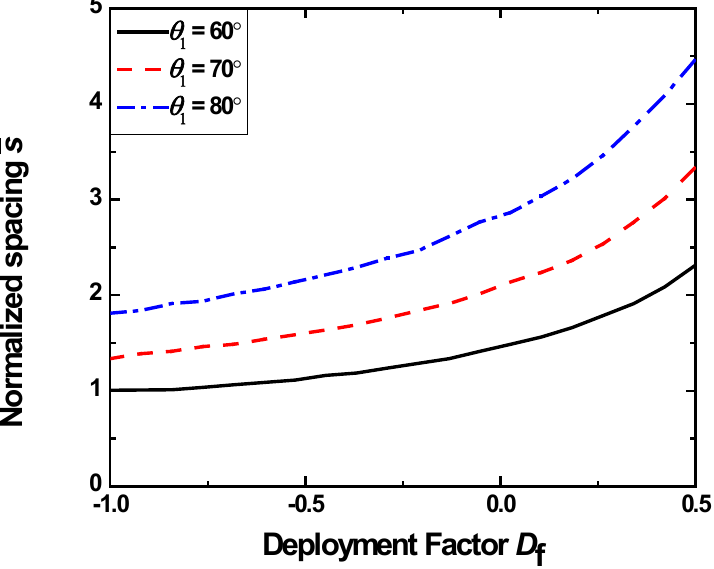
Figure 5. Contours of the predicted bending angle as a function of the normalized spacing and the deployment factor.